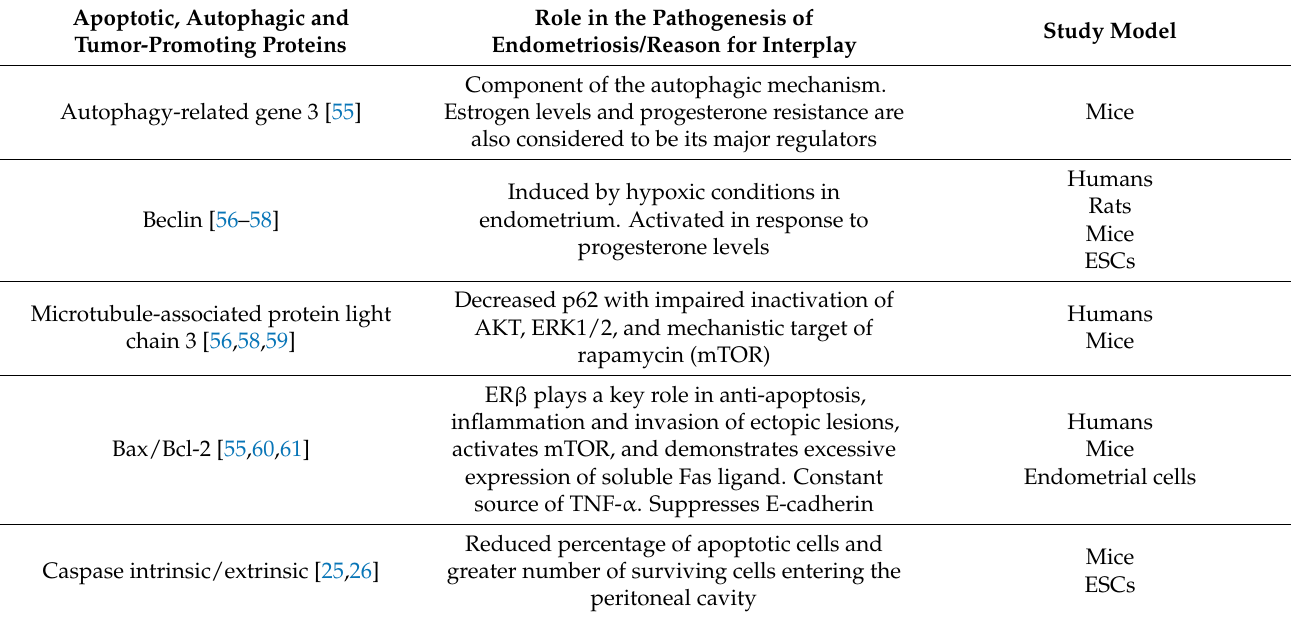
Table 5. Important apoptotic and autophagic proteins in the pathogenesis of endometriosis. Apoptotic, Autophagic